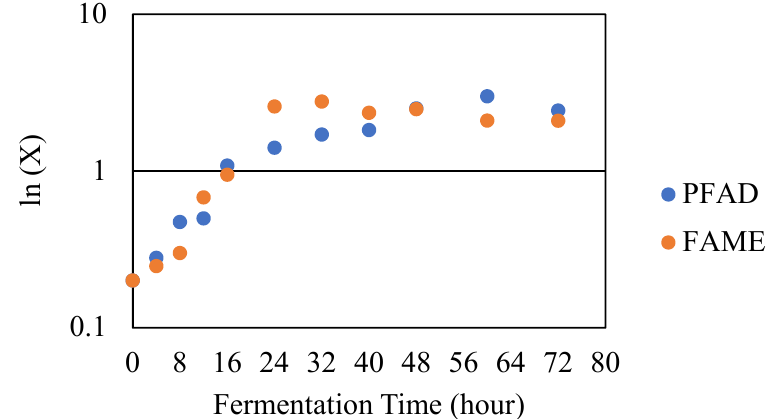
Figure 4. Kinetic growth of P. aeruginosa PAO1 by PFAD and FAME as a source of carbon.